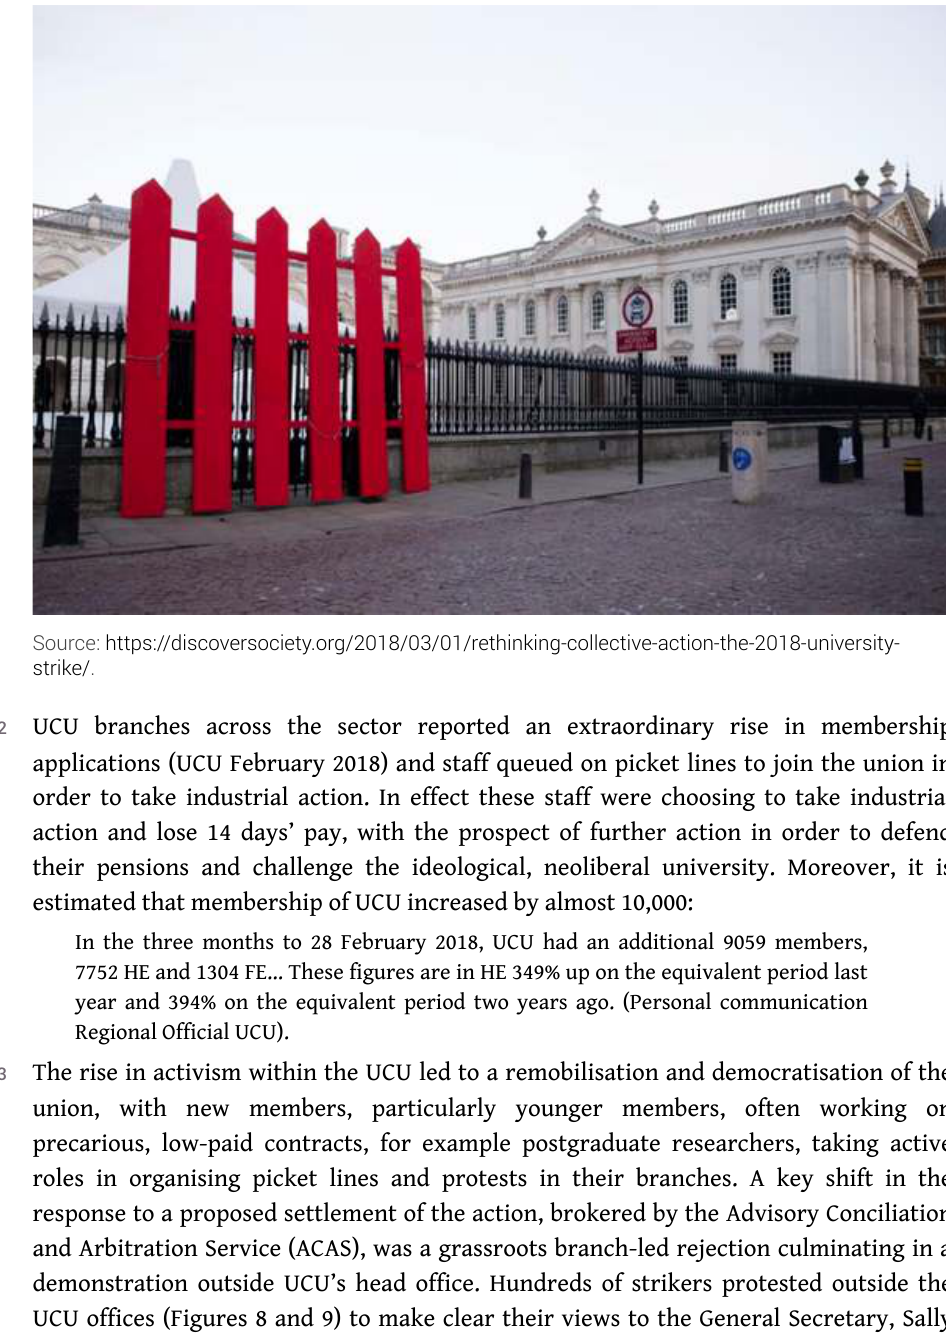
Figure 7. RAF action at Cambridge